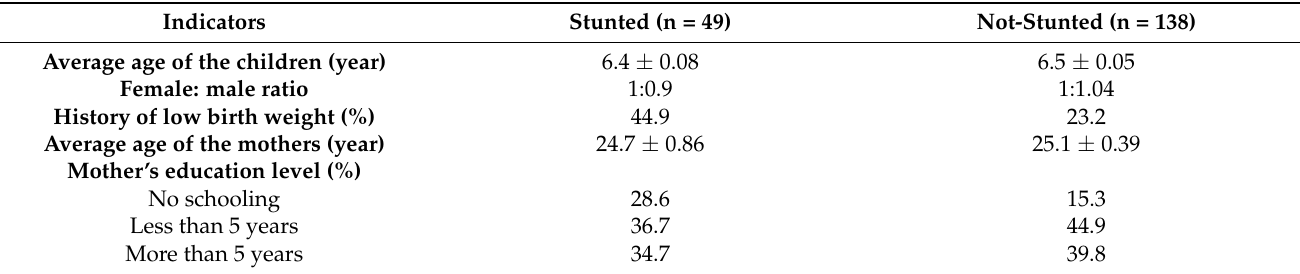
Table 2. Background characteristics of the study population (n =